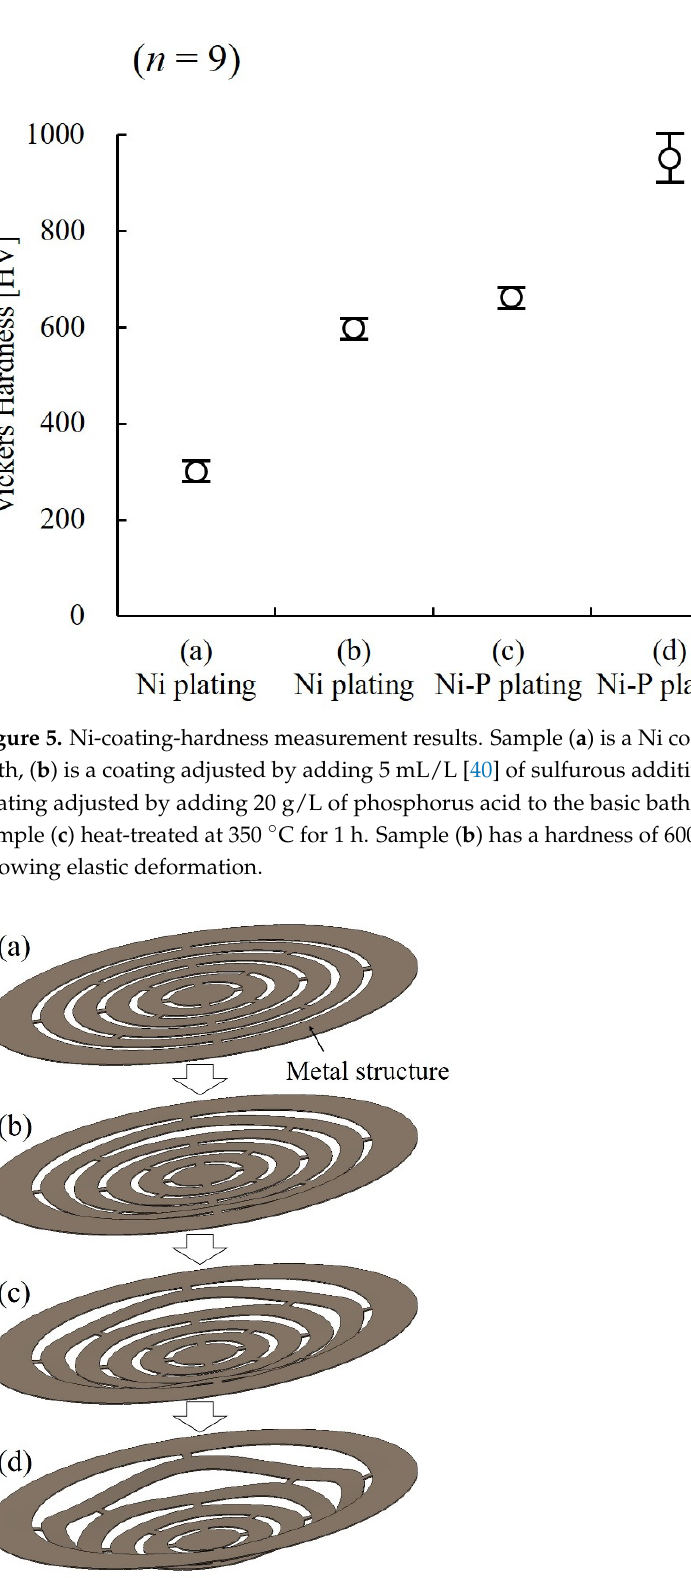
Figure 6. Schematic of deformation of metal structures due to hydrodynamic forces. ( a ) Initial state of the metal structure. ( b ) When the hydrodynamic forces are small, the deformation of the metal structure is small. ( c , d ) The greater the hydrodynamic forces is, the greater the deformation of the metal structure.